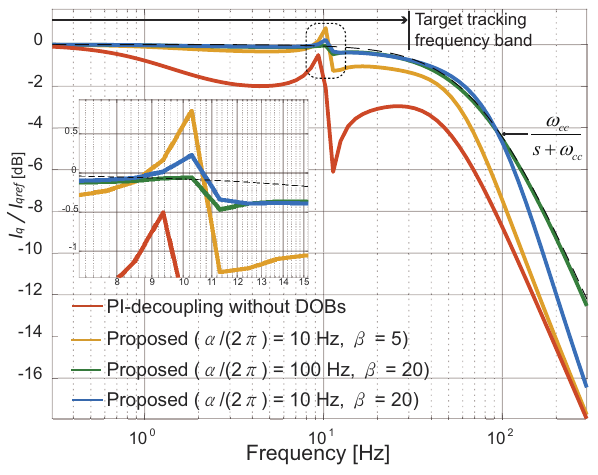
Figure 8. The q -axis current tracking frequency response (sine sweep) under parameter